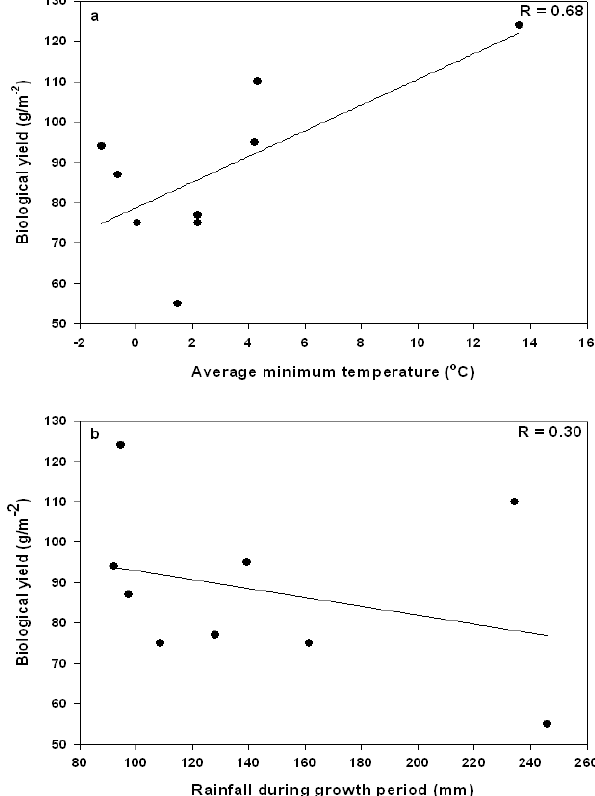
Fig. 3. Relationship between biological yield and average mini- mum temperature (a) and rainfall (b) during growth